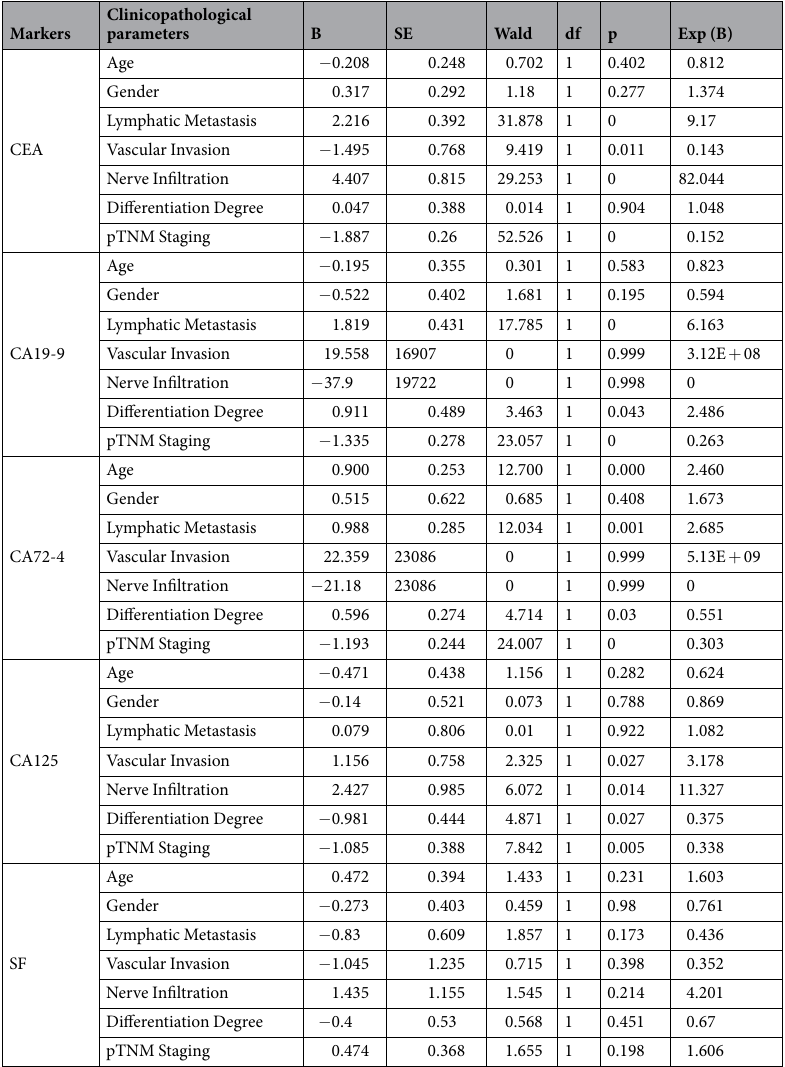
Table 3. Binary logistic regression analysis of biomarkers and CRC clinicopathological